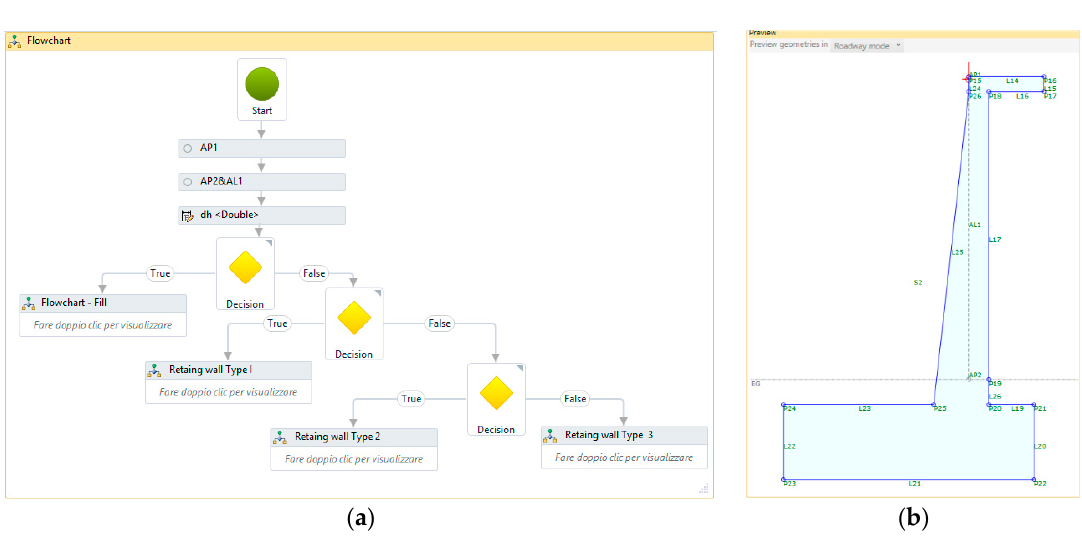
Figure 12b. Infrastructures 2020 , 5 , x FOR PEER REVIEW